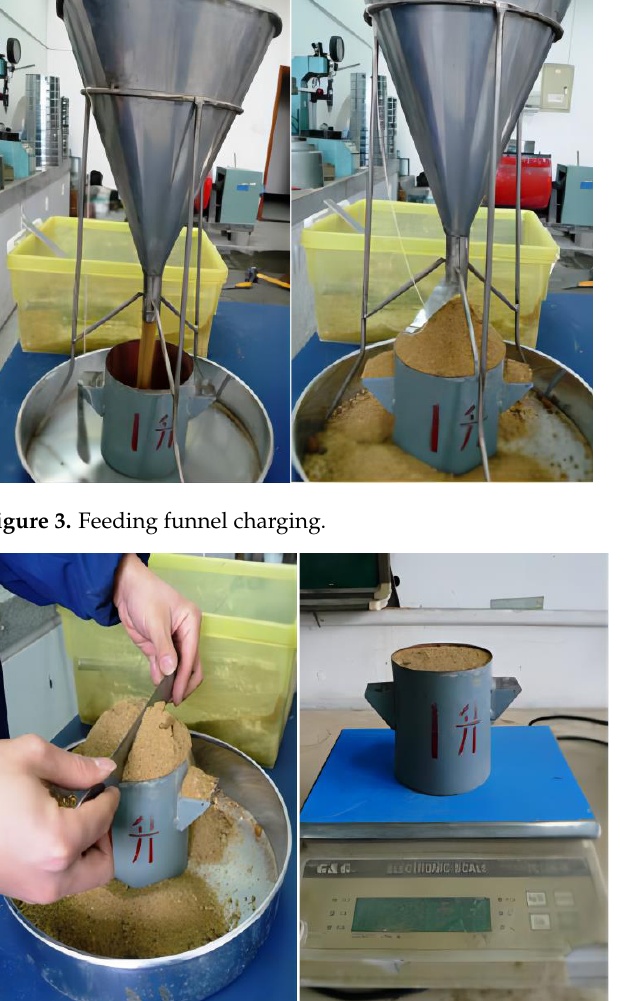
Figure 4. Scrape